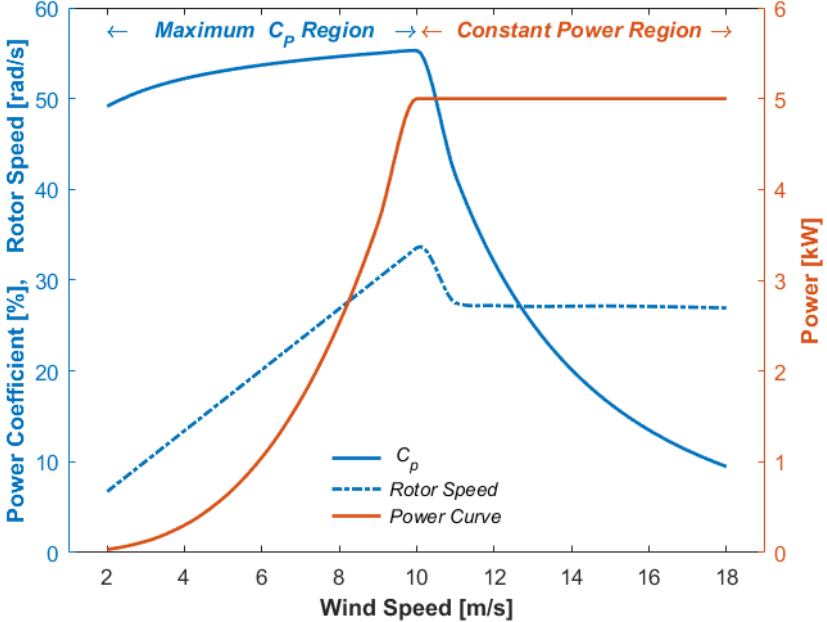
Figure 16. Power coefficient, power, and rotor speed against operating wind speed at a pitch angle of − 3° generated applying variable speed operations and maximum power tracking principles.